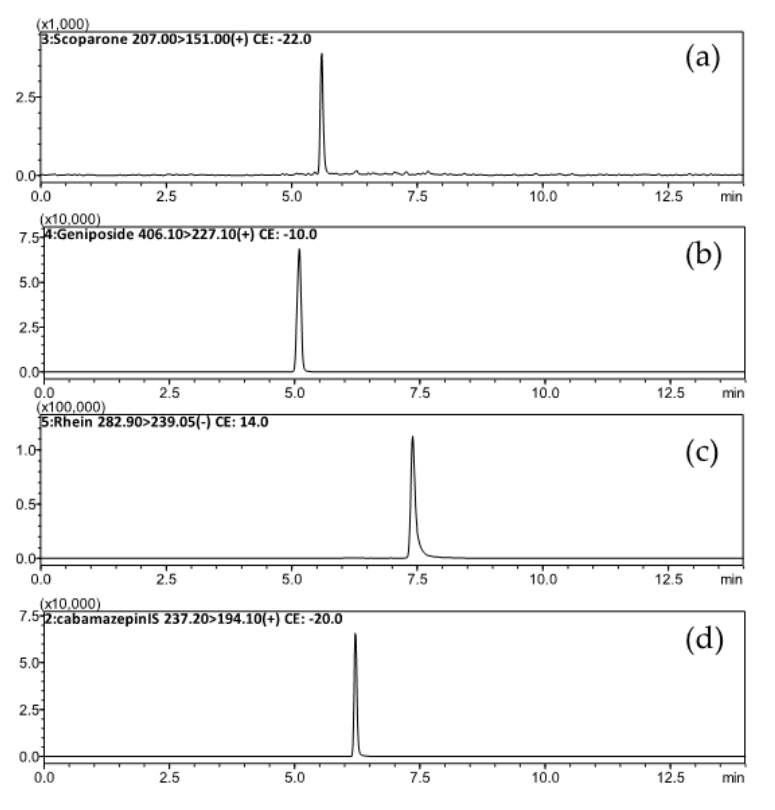
Figure 2. Typical MRM chromatograms of plasma samples collected 180 min after oral administration of the herbal formula Yin-Chen-Hao-Tang (3 g/kg): ( a ) scoparone (6.2 ng/mL) RT: 5.6 min, ( b ) geniposide (287.4 ng/mL) RT: 5.1 min, ( c ) rhein (350.3 ng/mL) RT: 7.4 min and ( d ) internal standard: Carbamazepine (10 ng/mL) RT: 6.2 min.